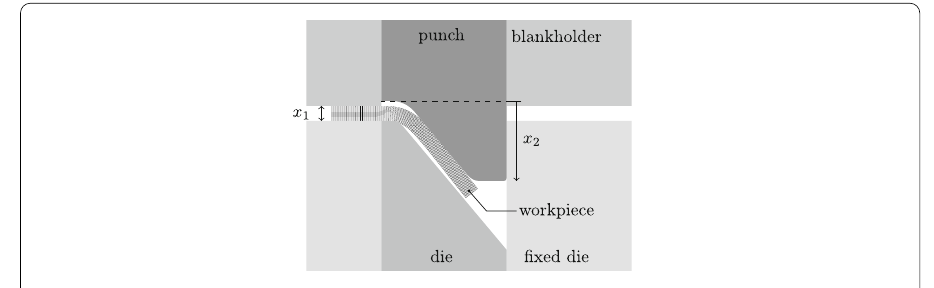
Fig. 3 Schematic representation of the demonstrator process and Finite Element mesh